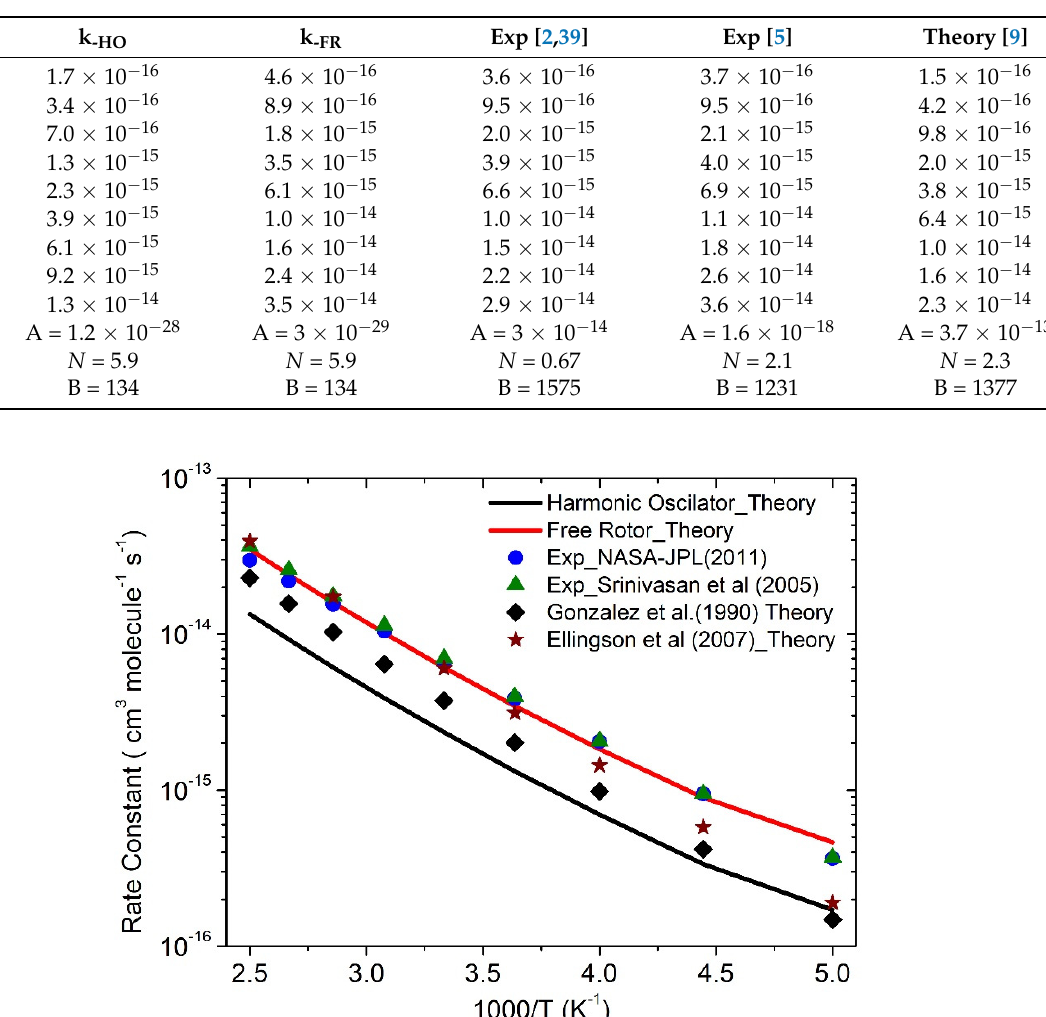
Table 2. Comparison of calculated rate constants ( cm 3 molecule -1 s -1 ) and literature rate constants for the · OH + CH 4 → CH 3 + H 2 O.